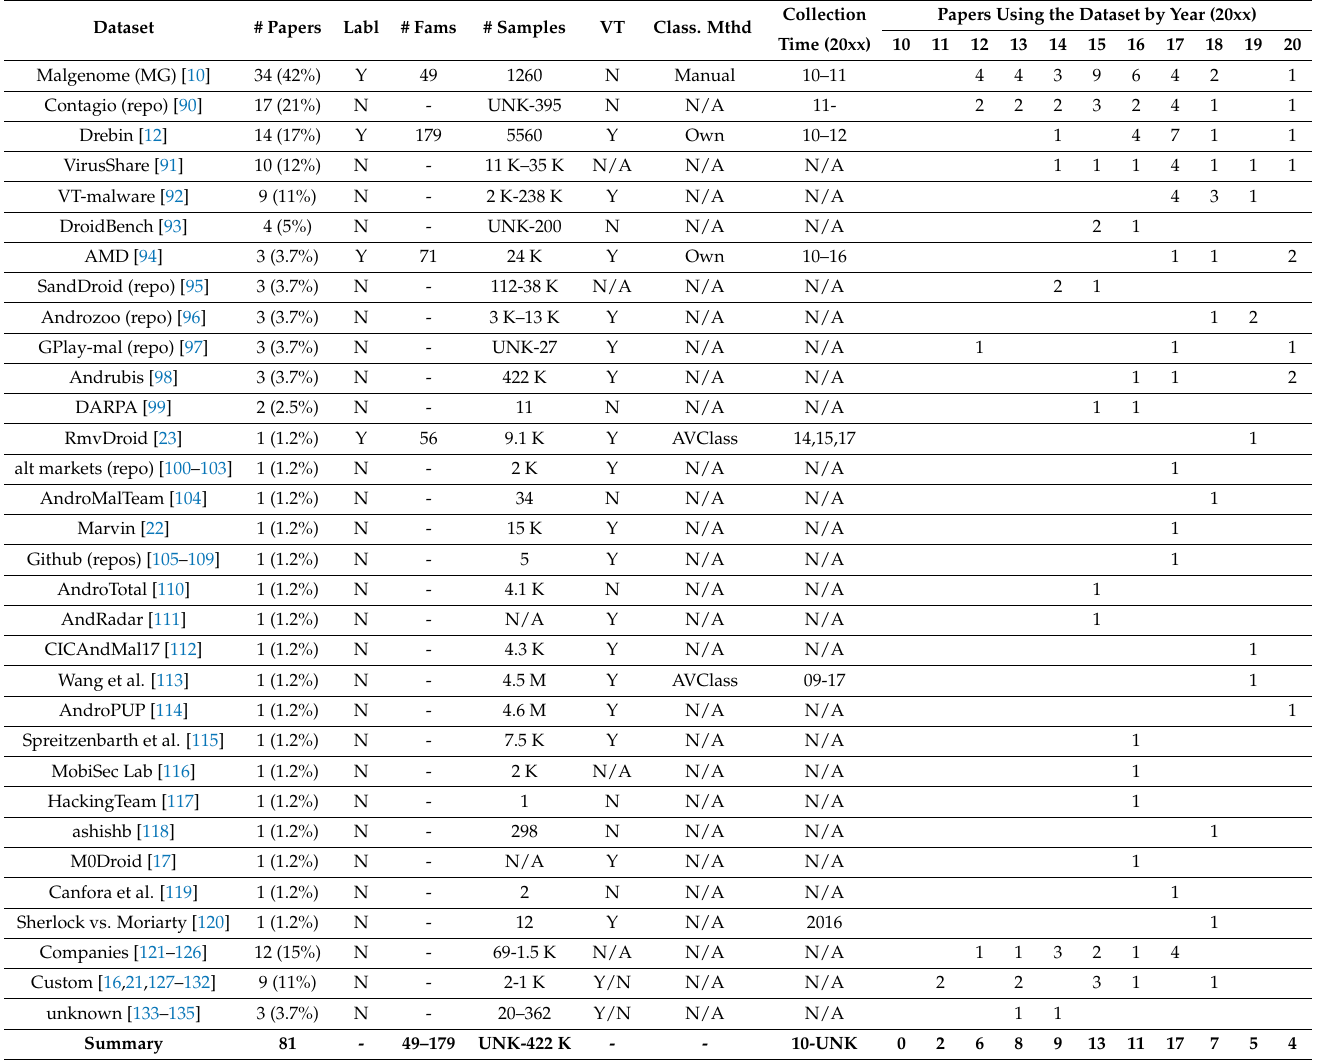
Table 3. Android malware datasets used in security conferences’ papers over the last decade. In # samples column, in case of a repository (repo), we include the range of samples from that repo used by the papers. We use UNK whenever it is not possible to identify # samples from that repo (e.g., when several datasets/repos are used collectively, and authors do not provide the # samples used from each of them). The Summary row represents the sum of the papers we analyzed and other key information where relevant/easily extracted information can be included, e.g., papers using dataset/year.